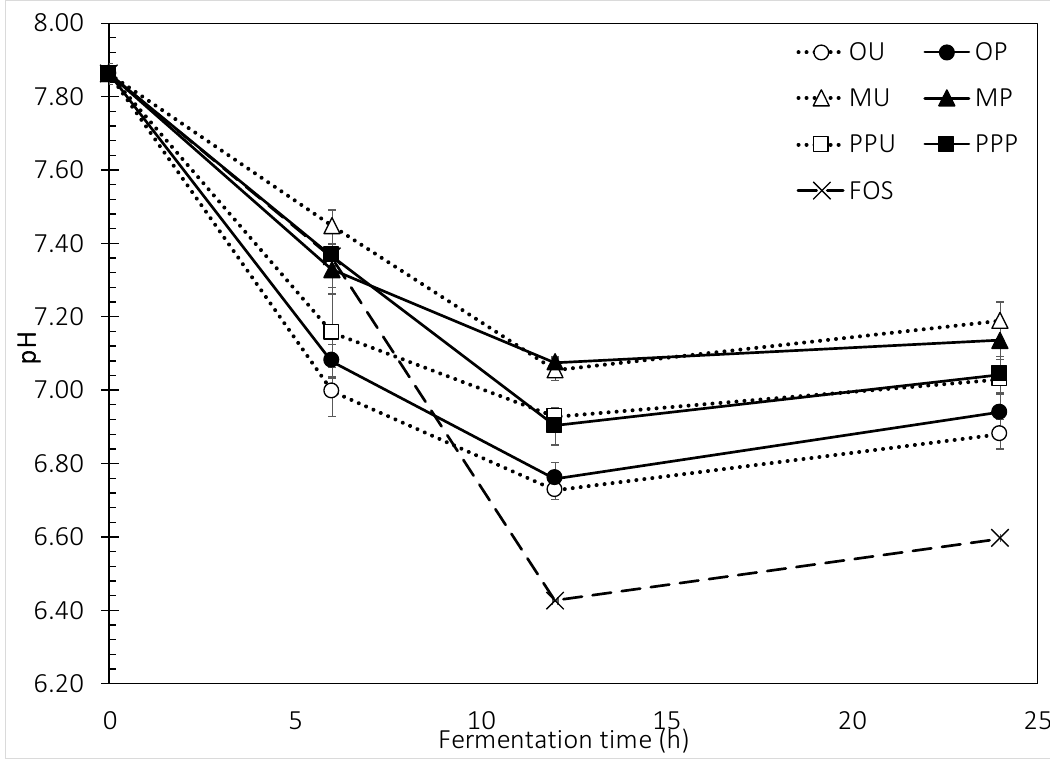
Figure 3. Changes in pH during in vitro fermentations of untreated and HHP-treated fruit peels. Error bars show SD; some error bars are too small to see; n = 3. OU—orange untreated, OP—orange HHP-treated, MU—mango untreated, MP—mango HHP-treated, PPU—prickly pear untreated, PPP— prickly pear HHP-treated, FOS—fructo-oligosaccharides.